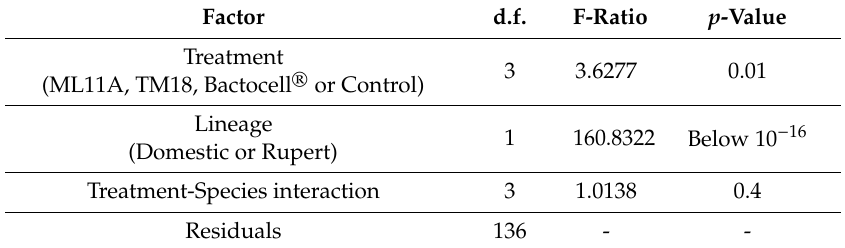
Figure 6. Mean body weight (g) of Domestic and Rupert brook charr after 120 days of daily treatment exposure ( n = 18 fish per treatment). Bars are least-square (LS) mean estimates, and horizontal lines represent the 95% confidence interval for each mean estimate. Control: no probiotic treatment. Table 5. Two-factor ANOVA of the means per-fish weight at the end of the experiment, with Treatment and Lineage as explanatory variables.